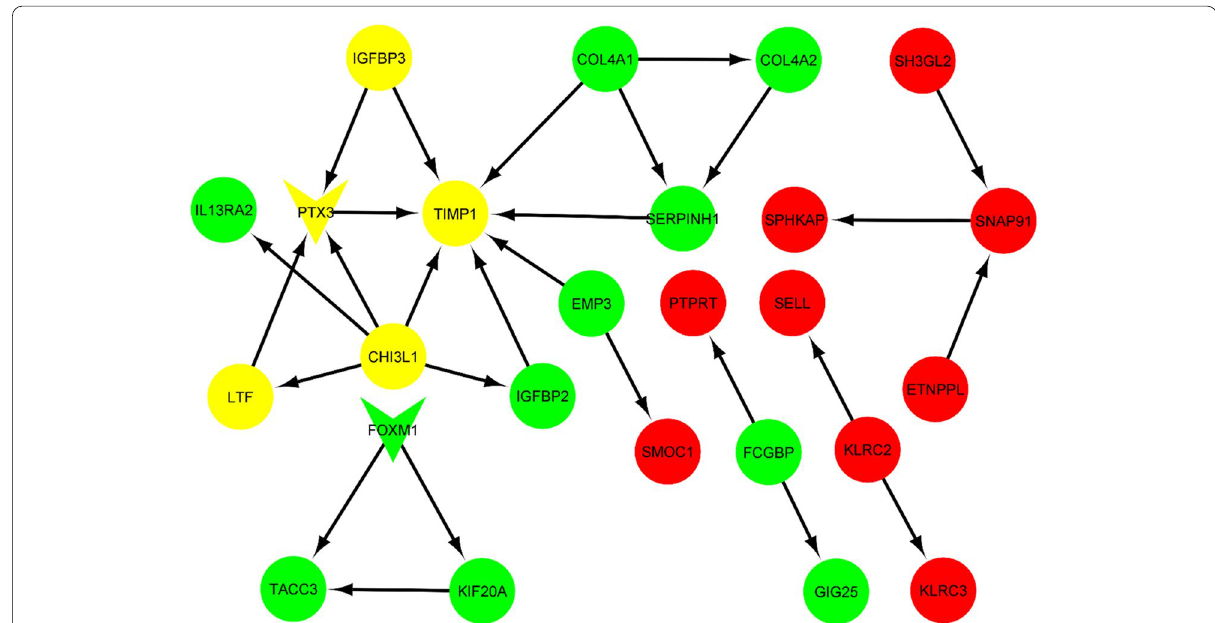
Fig. 4 Protein–protein interaction network illustrated by Cytoscape software. The 25 genes of the top 20 DEGs interact with each other amongst them TIMP1, CHI3L1 and PTX3 have the most interactions. The green nodes represent upregulated genes, whereas nodes in red represent down‑regulated genes. The Yellow circles contain upregulated hub DEGs with interactions to PTX3. Transcription factors are in triangular shape. The arrows represent the direction of